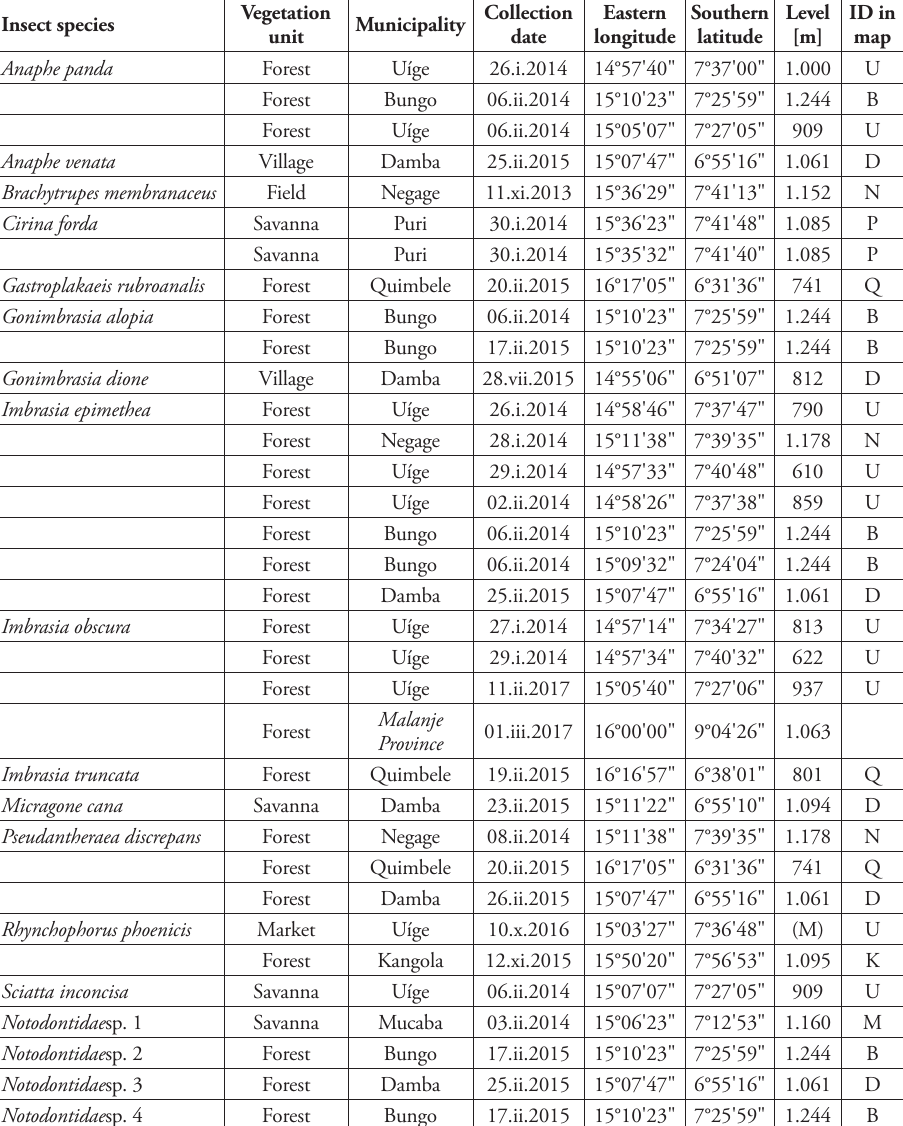
Table 2. Alphabetical order of insect species with vegetation unit, collection date, GPS coordinates (DMS); map ID according to Fig. 1c in square brackets; [B] Bungo, [D] Damba, [K] Kangola, [M] Mu- caba], [N] Negage, [P] Puri], [Q] Quimbele, [U]